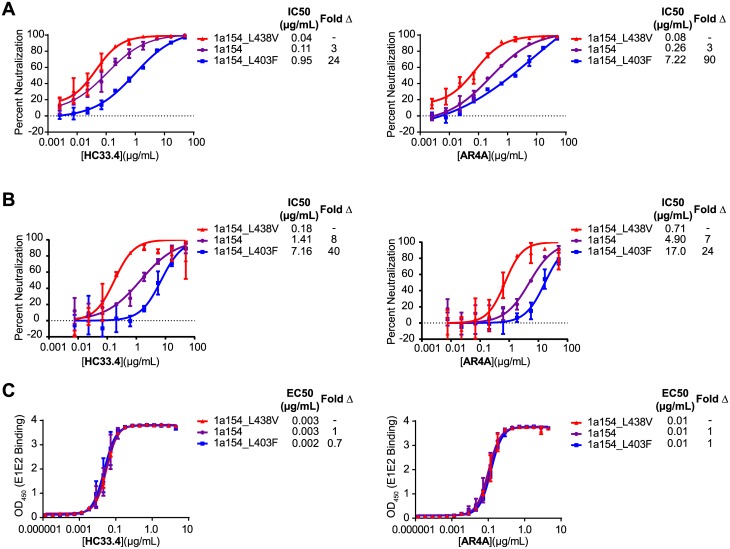
L403F and L438V confer similar-magnitude changes in HCVpp and HCVcc neutralization sensitivity to HC33.4 and AR4A, but no changes in bNAb binding.(A) L403F confers neutralization resistance and L438V confers increased neutralization sensitivity to both HC33.4 and AR4A. The indicated mutations were introduced into E1E2 variant 1a154 (H77), and HCVpp were generated. Neutralization of wild type and mutant HCVpp by serial dilutions of HC33.4 or AR4A was measured. Each point is the mean of two replicate values, and error bars indicate standard deviations. 50% inhibitory concentration (IC50) of each bNAb/HCVpp combination and fold change in IC50 relative to 1a154_L438V are indicated. (B) Neutralization of replication competent cell culture virus (HCVcc) generated with wild type 1a154 (H77) or mutant E1E2. Each point is the mean of triplicate values, and error bars indicate standard deviations. 50% inhibitory concentration (IC50) of each bNAb/HCVcc combination and fold change in IC50 relative to 1a154_L438V are indicated. (C) L403F and L438V do not change binding of HC33.4 or AR4A to E1E2 protein. Binding to wild type and mutant E1E2 protein by serial dilutions of HC33.4 or AR4A was measured in an ELISA. Each point is the mean binding measured in two independent experiments performed in duplicate, with error bars indicating standard deviations between experiments, except binding at the lowest 7 bNAb concentrations, which was tested in only one experiment. BNAb concentration resulting in half-maximal binding (EC50) of each bNAb/E1E2 combination and fold change in EC50 relative to 1a154_L438V are indicated.